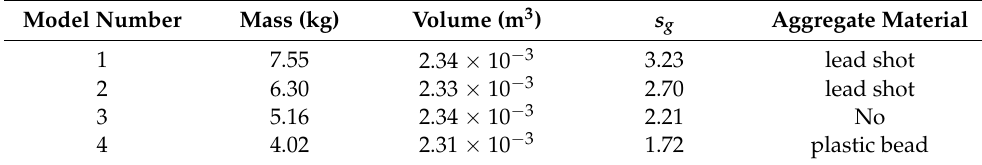
Table 1. A summary of the ACM models (with identical configuration of 5 × 6) in this work. Model Number